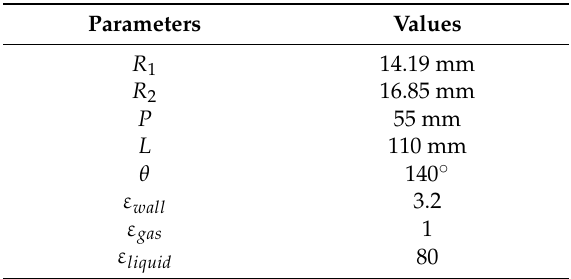
Table 2. Design parameters of helical capacitance sensor and geometry of pipe.